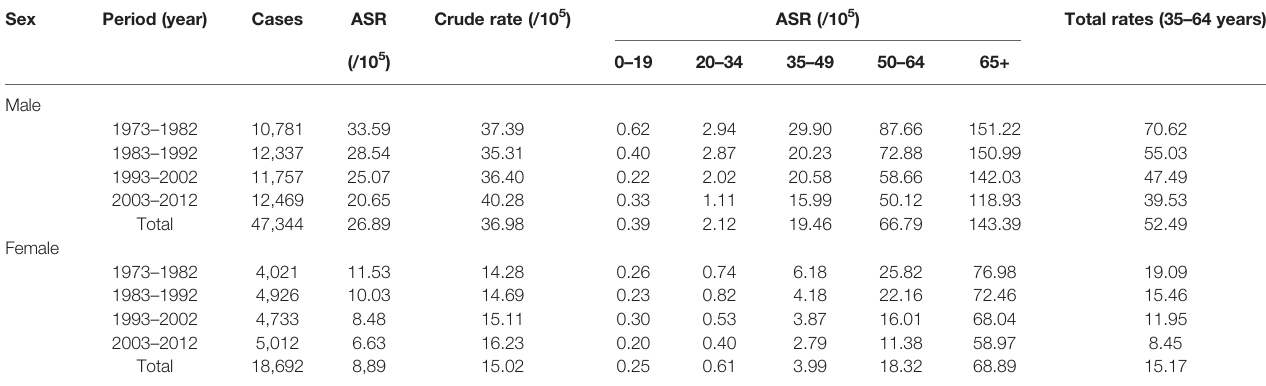
TABLE 4A | Age-standardized rates (ASR) of HCC in Shanghai from 1973 to 2012. Sex Period (year)